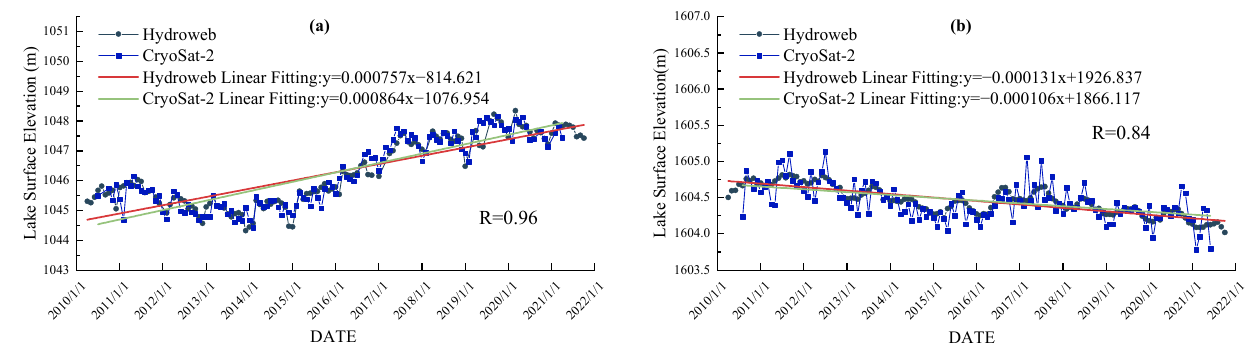
these two lakes’ monthly variations in lake surface elevation.